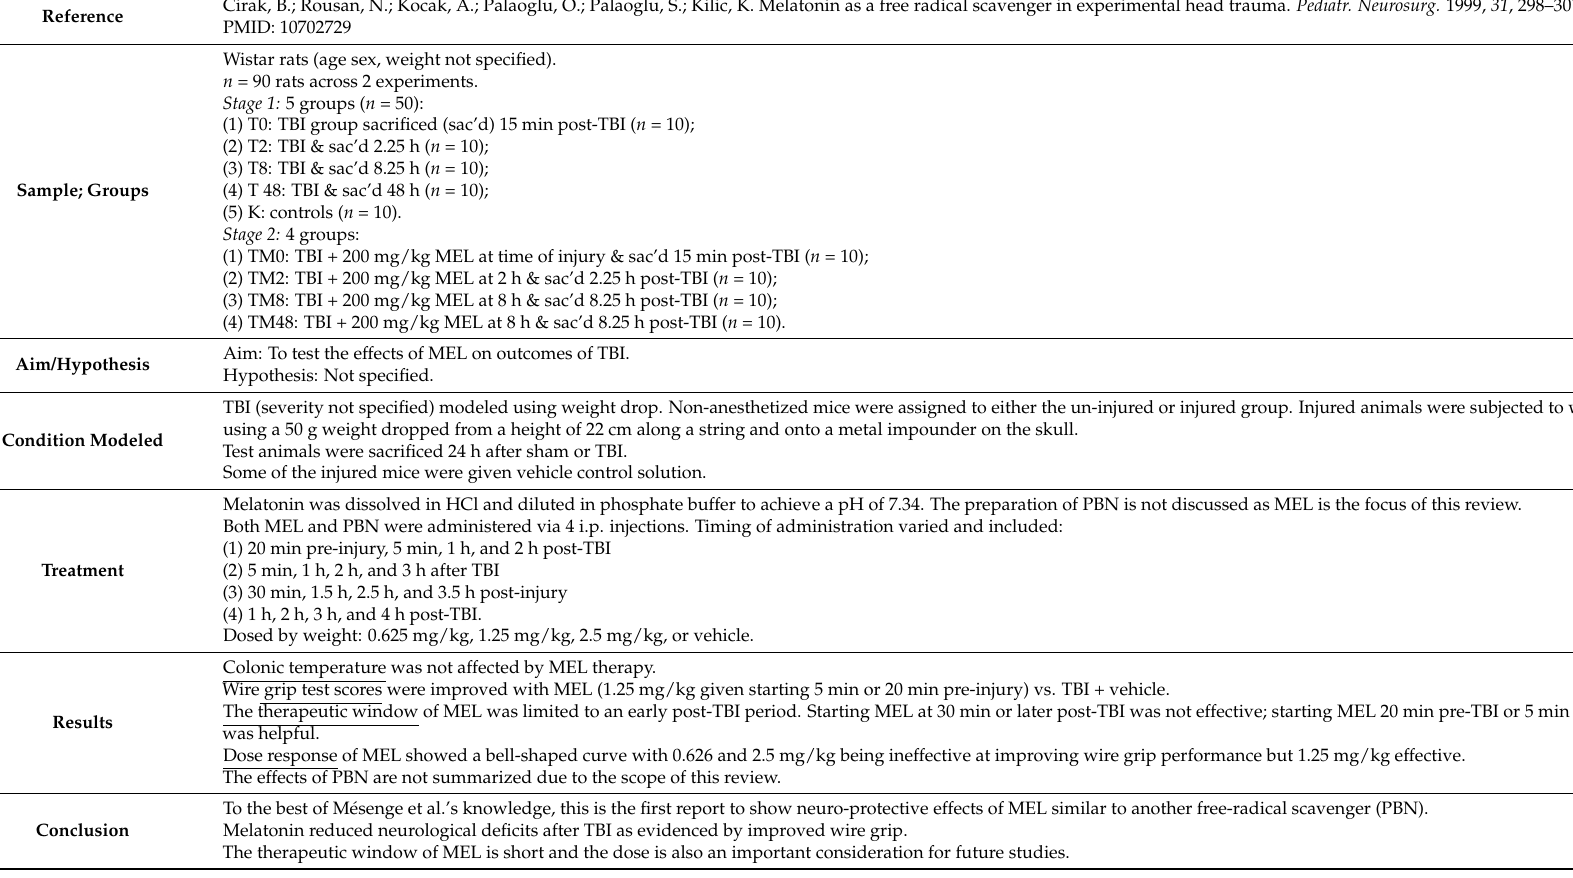
Table A2. Cirak et al. (1999) Study